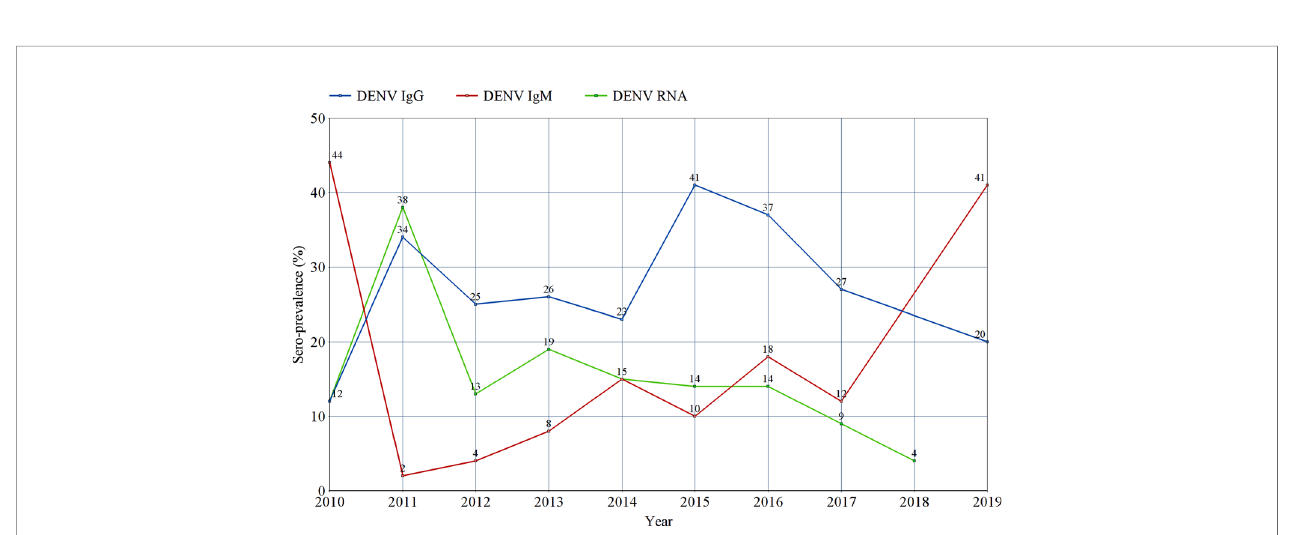
FIGURE 7 | Tracking the prevalence estimates of Dengue-speci fi c IgG, IgM, and Dengue virus RNA in Sub-Saharan Africa between 2010 and 2019. Each point represents the random effects pooled prevalence of the speci fi ed infection marker from studies reporting sample collection in the corresponding year. No prevalence estimates of IgG or IgM were reported in 2018, nor for RNA in